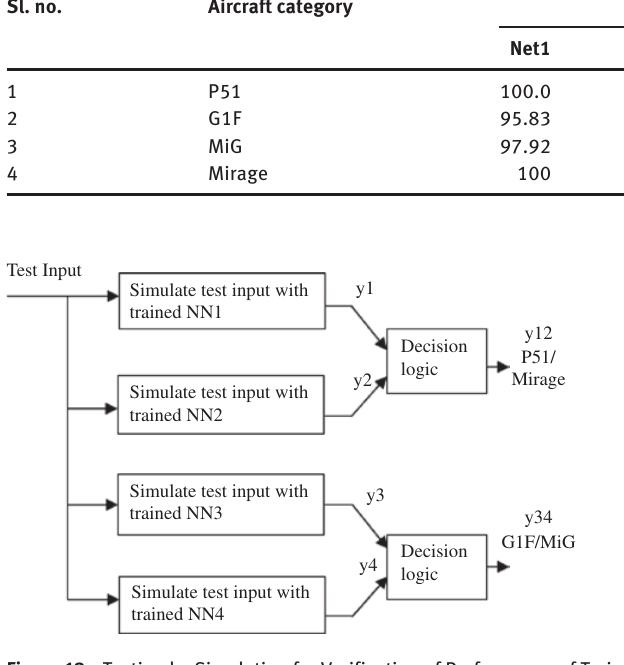
Table 3: Efficiency of Training for Training Data Set. Sl. no.